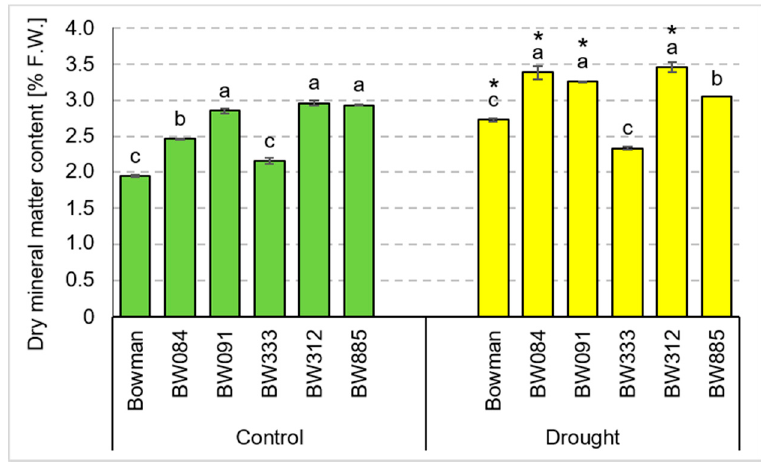
Figure 9. Contents of the dry mineral matter in grains of the analyzed genotypes under the optimal watering (control) conditions and after the drought stress (the pot experiment). The mean values ± (SD) marked with the same letters (separately for the control and drought-stressed plants) are not significantly different, according to Duncan’s test ( p ≤ 0.05). Asterisks denote significant difference in comparison of values reported in each genotype between the control and drought conditions according to Student’s t -test. Details are given in the text.